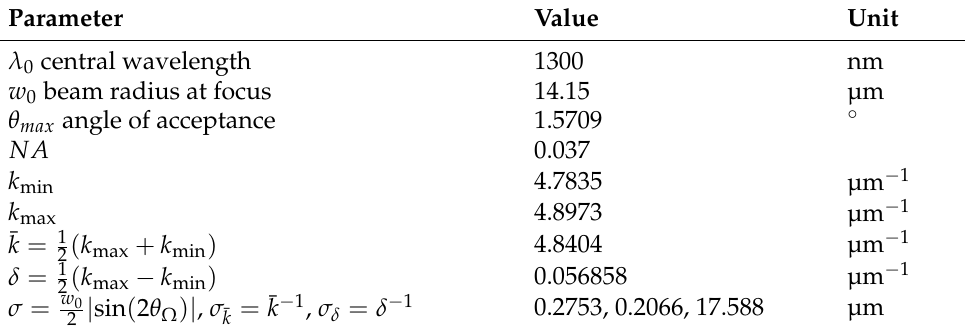
Table 1. List of parameters: The central wavelength and the wavenumbers k min and k max are determined through the specifications of the used swept-source. The beam radius and the angle of acceptance were found through calibration (see Section 5.1). The numerical aperture NA was calculated from the angle of acceptance. The parameter σ is given for a typical tilting angle θ Ω in our